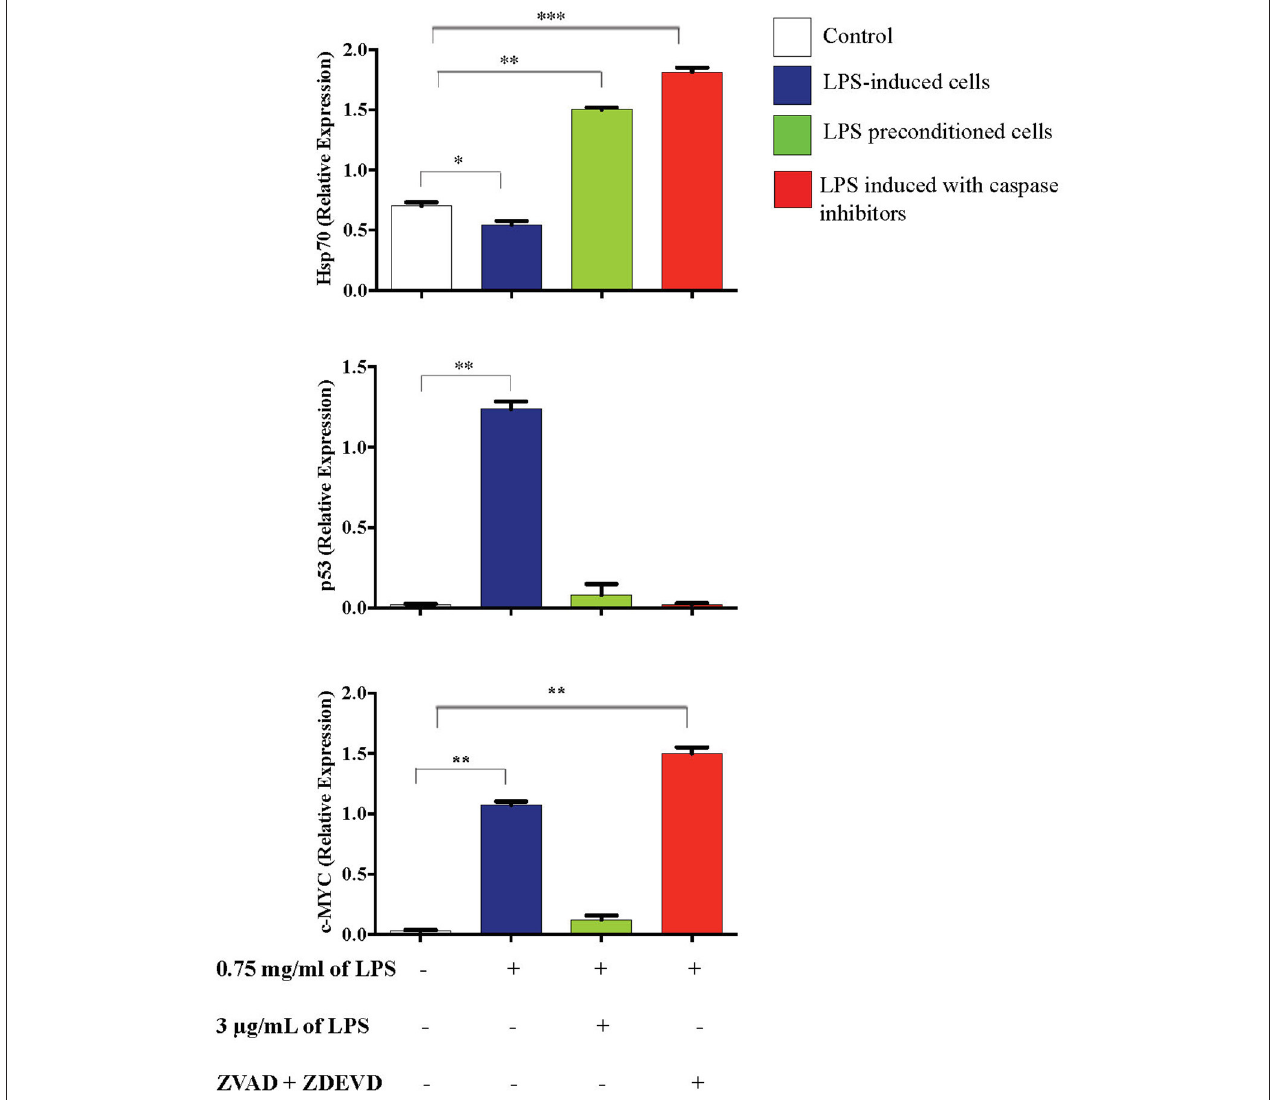
FIGURE 22 | Expressions of Hsp70, p53, and c-MYC. The expressions of Hsp70, p53, and c-MYC were determined in whole cell lysates by ELISA. Bars represent data from three independent experiments. Hsp70, p53, and c-MYC expressions in LPS-induced cells, LPS-preconditioned cells, and LPS-induced cells with caspase inhibitors were compared to the control. * p < 0.05, ** p < 0.01, *** p < 0.001 as determined by one-way ANOVA with Bonferroni’s